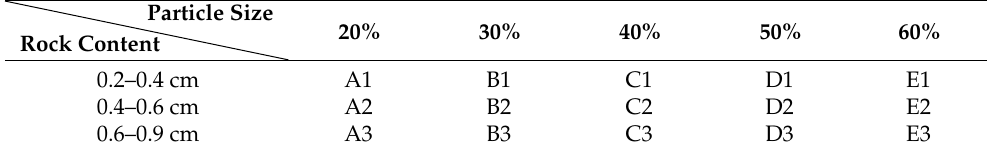
Figure 1. Raw material of soil–rock mixture: ( a ) silt, ( b ) rock. Table 2. Mixing ratio scheme of soil and